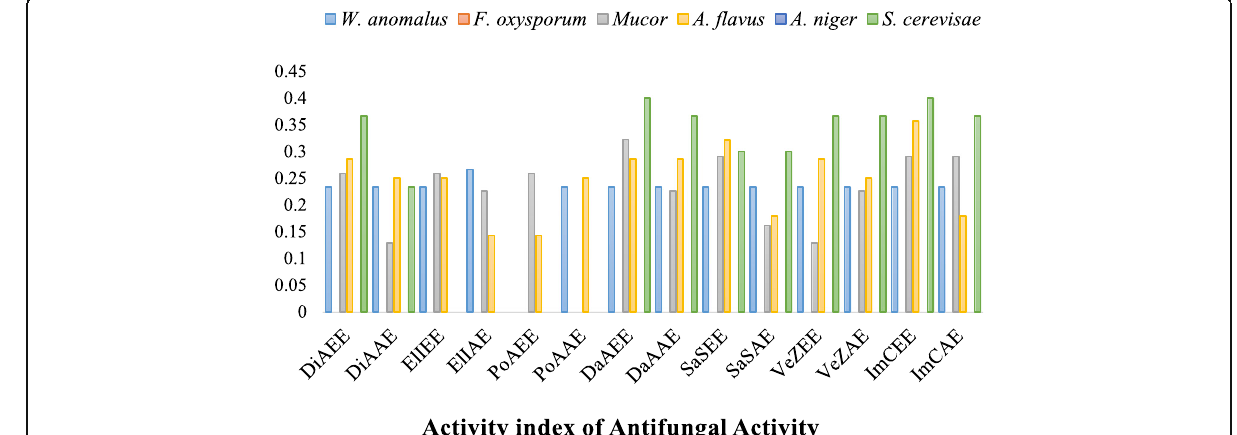
Fig. 7 Activity Index of antifungal activity of selected ethanol and acetone plant extracts